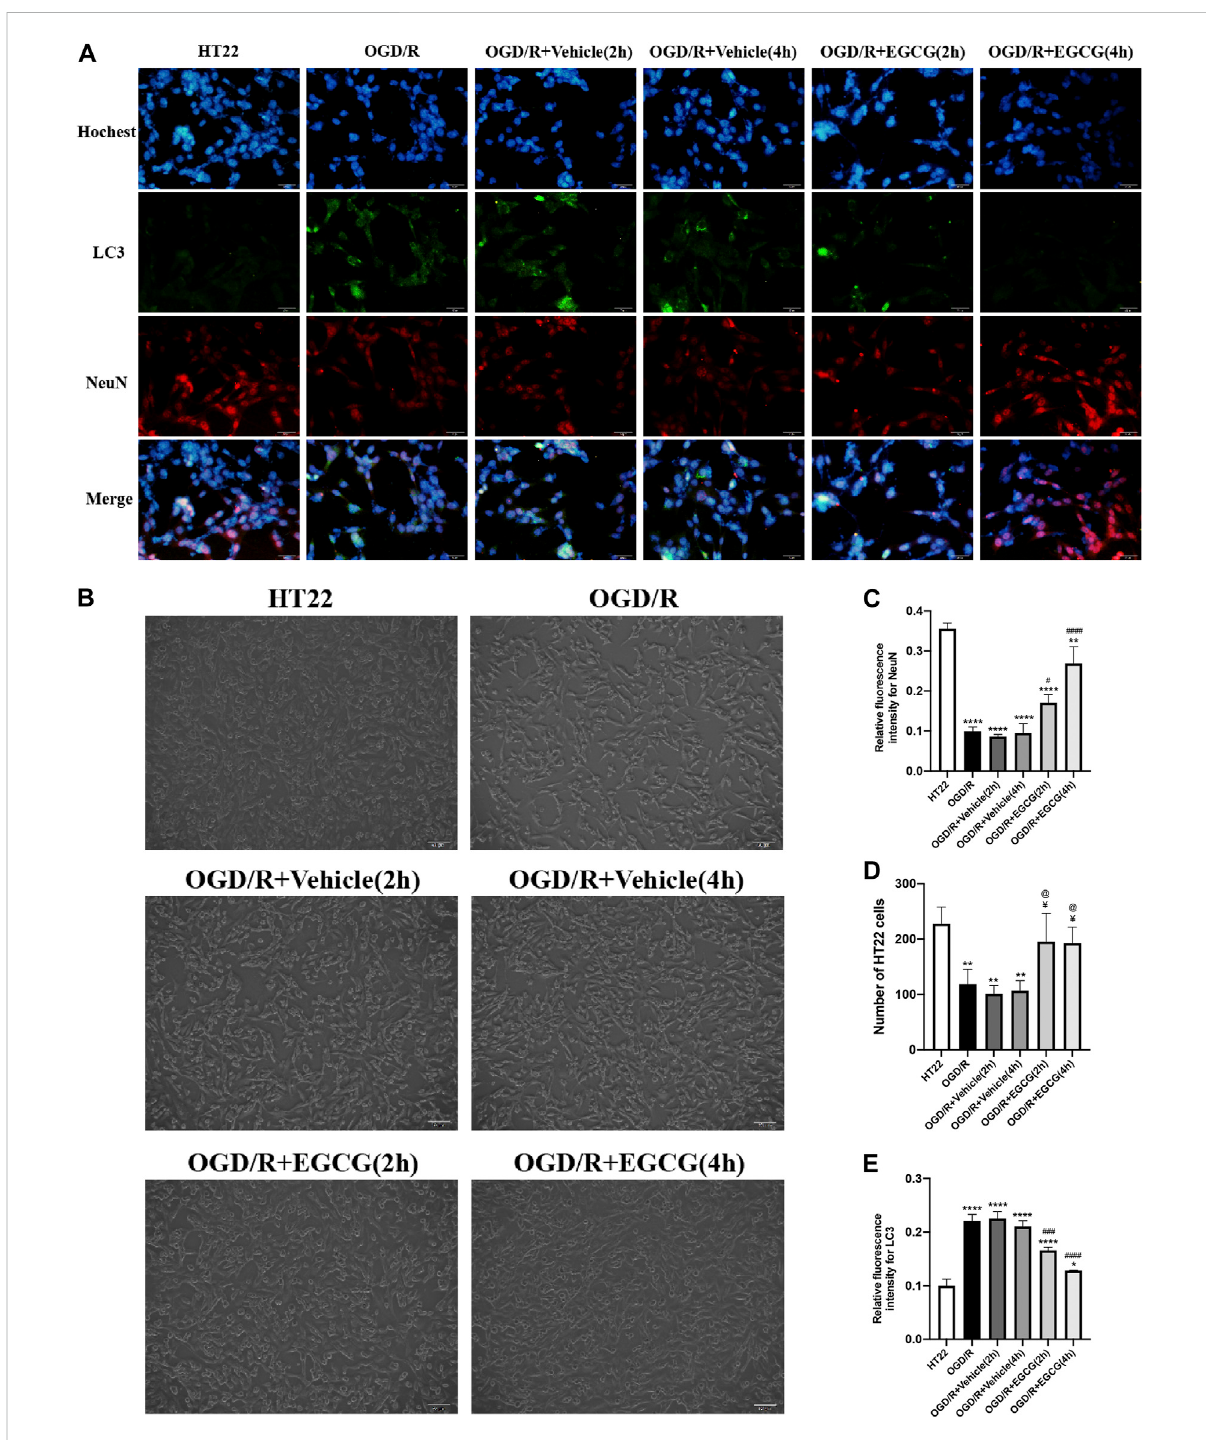
FIGURE 5 EGCG protected HT22 cells from oxygen-glucose deprivation/reoxygenation (OGD/R) damage. (A) Immuno fl uorescent staining for NeuN (C) and LC3 (E) (scale bar = 50 μ m). (B,D) The number of HT22 cells in different groups. Each experimental datum was presented as mean ± standard deviation ( n = 3 per group). * p < 0.05, ** p < 0.01, **** p < 0.0001 versus HT22 group, # p < 0.05, ### p < 0.001, #### p < 0.0001 versus OGD/R group, ¥ p < 0.05 versus OGD/R + Vehicle (2 h) group, @ p < 0.05 versus OGD/R + vehicle (4 h)